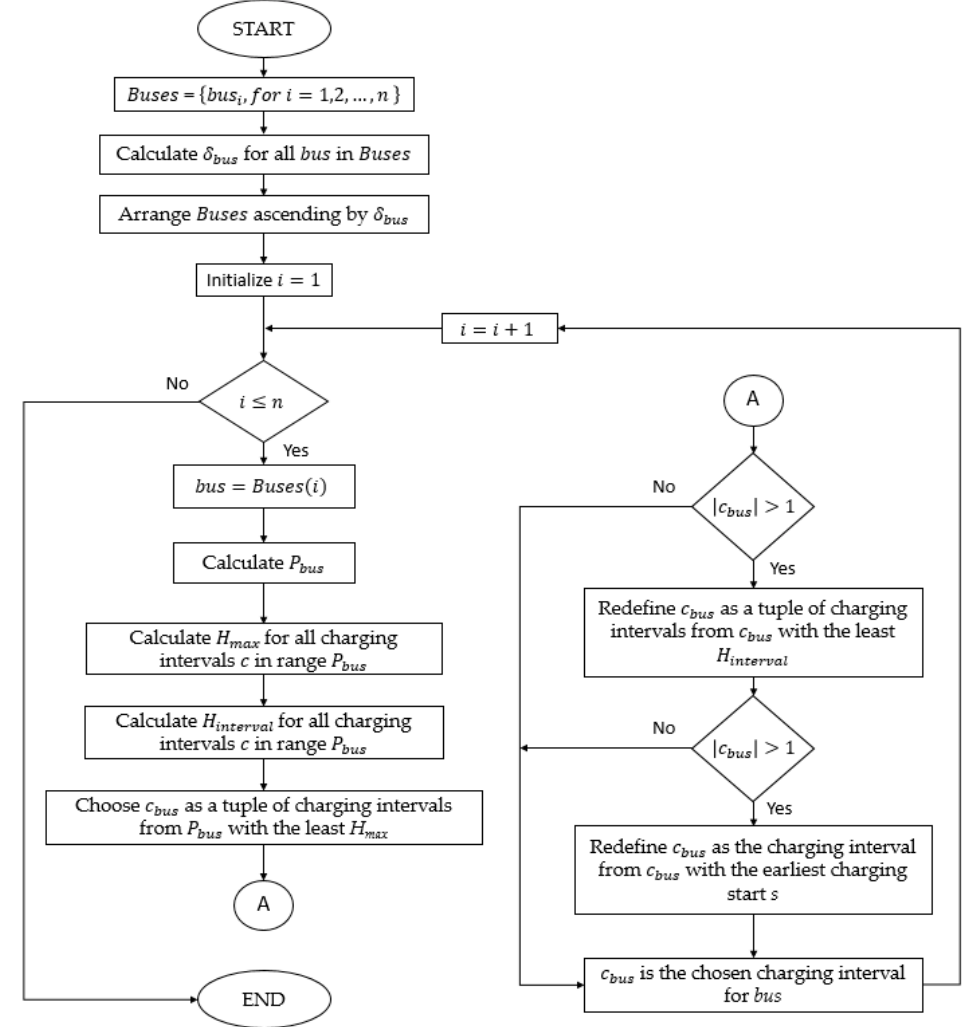
Figure 7. Flowchart representing the heuristic algorithm.